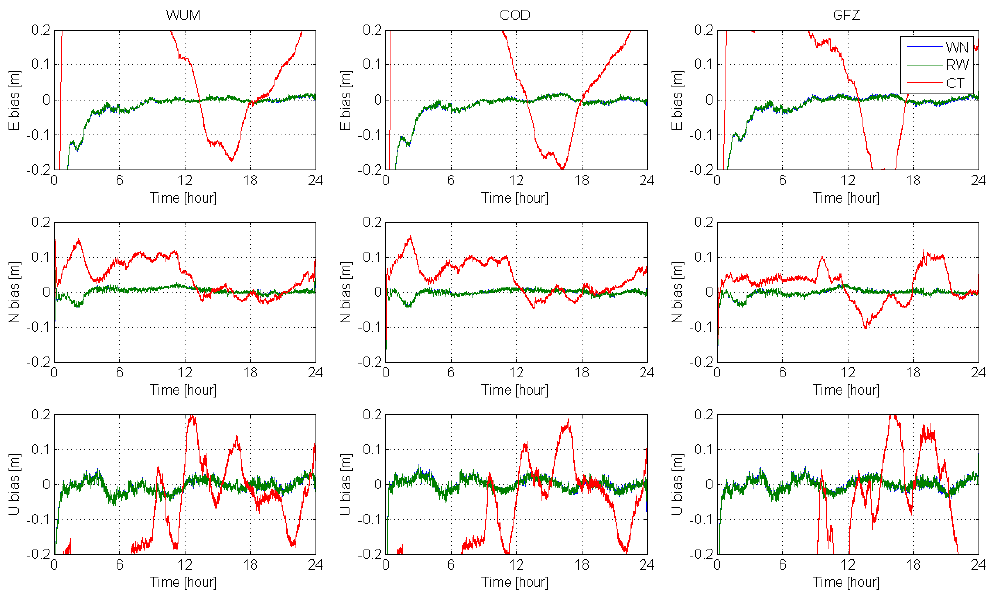
Figure 8. Positioning result of GPS / BDS PPP at station BALA on DOY 2, 2018, using constant, random walk and white noise methods.